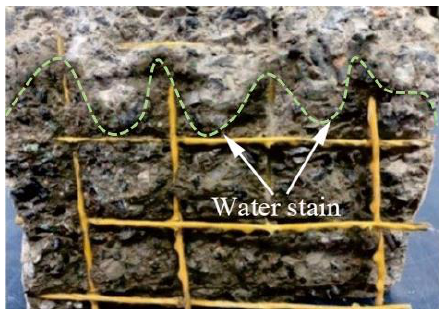
Figure 6. Water penetration path of the test piece.